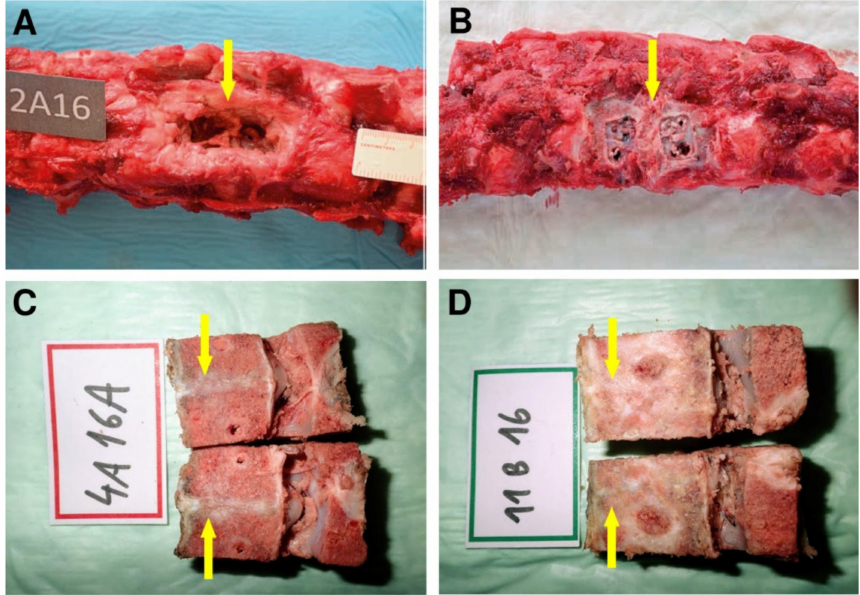
Figure 7. The autopsy photo shows a detail of the L2/3 segment of the spine of an animal from group A2 after 16 weeks of experiment ( A ). The arrow indicates the location after explantation of the osteosynthetic material with the presence of fibrous reaction. The excised segment of the spine of an animal from group B2, the arrow mark segment L2/3 after osteosynthetic explantation material, the fibrous reaction is not present, on the contrary, a partial bone overgrowth is expressed at the site after removal of anterior implant fixation plates ( B ). Fibrous reaction without osseous fusion was observed macroscopically as a white line (yellow arrow) at the site of bone autograft implantation of the cadaveric lumbar spine at L2/3 level of Group A ( C ). Macroscopically observed interbody fusion of group B2, 16 weeks after surgery ( D ). In contrast, the structure of the tissue of interbody fusion at the site of bioresorbable hybrid implant (BHI) implantation was solid (yellow arrow) like the surrounding bone with full osseous fusion as ( D